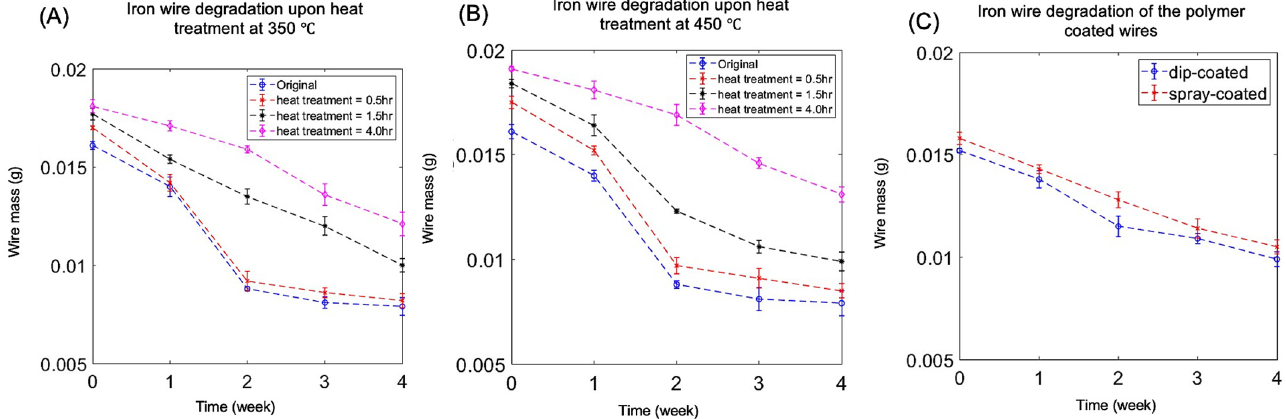
Figure 7. The relationship between the iron wire mass (g) and the types of surface treatment over time (week): ( A ) heat-treated at 350 °C, ( B ) heat-treated at 450 °C, and ( C ) polymer-coated wire.